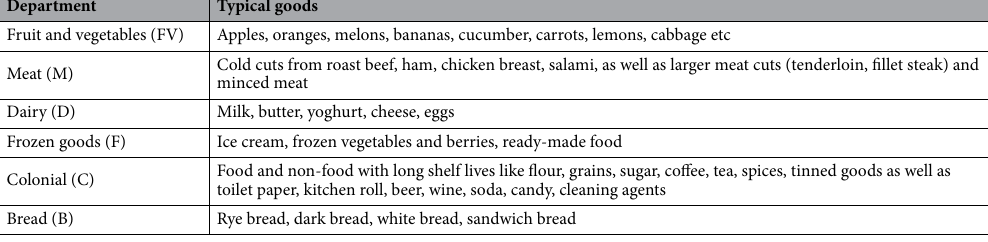
Table 1. Definitions of departments.